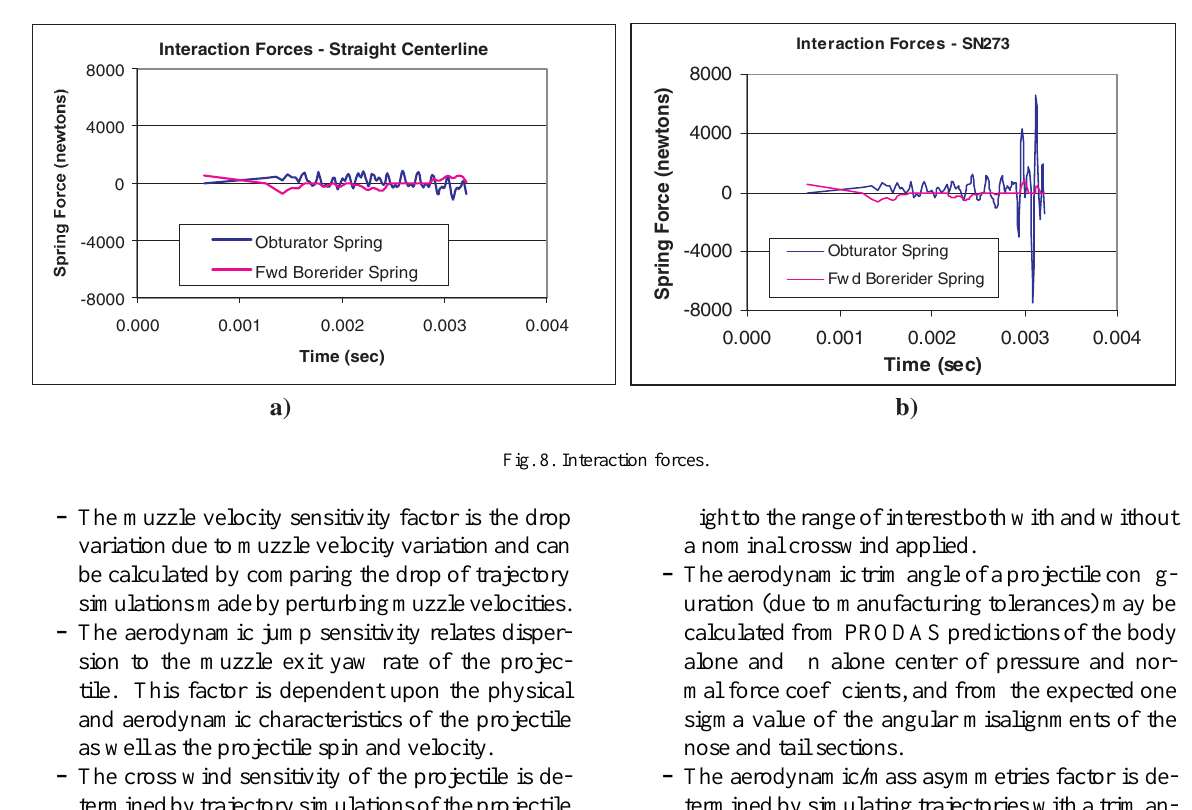
Fig. 7. Graphical representation of the XM881 lumped parameter model.